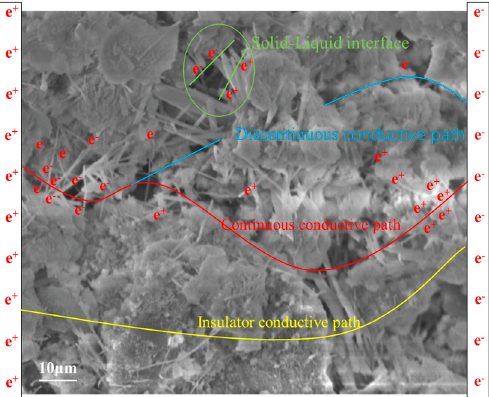
Figure 8. Schematic diagram of the microstructure of the filling body.